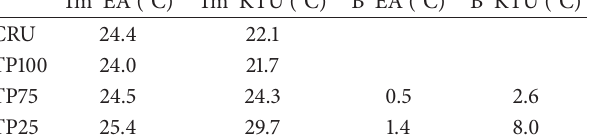
Table 3: Statistics of the model simulated mean OND temperature (Tm in ∘ C) over east Africa (Tm ∗ EA), averaged over 28 ∘ E–42 ∘ E, 12 ∘ S–5 ∘ N and that over KTU (Tm ∗ KTU), averaged over longi- tudes 34 ∘ E–38 ∘ E and latitudes 6 ∘ S–2 ∘ N for the control experiment (TP100), sensitivity experiments with topography reduced to 75% (TP75) and 25% (TP25), and the observed CRU data. B ∗ EA and B ∗ KTU are temperature biases over EA and KTU, respectively, with respect to TP100.